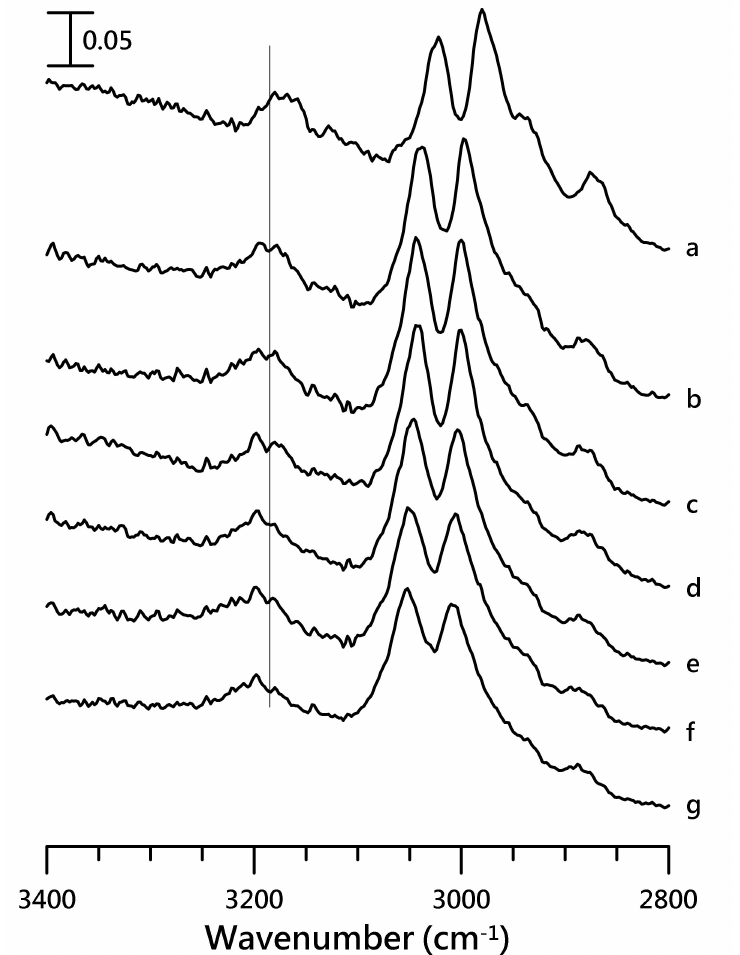
Figure 6. IR spectra of the [HMIM][NTF 2 ] / PVdF-co-HFP mixture having 10 wt.% of [HMIM][NTf 2 ], obtained at ( a ) ambient pressure and ( b ) 0.4, ( c ) 0.7, ( d ) 1.1, ( e ) 1.5, ( f ) 1.8, and ( g ) 2.5